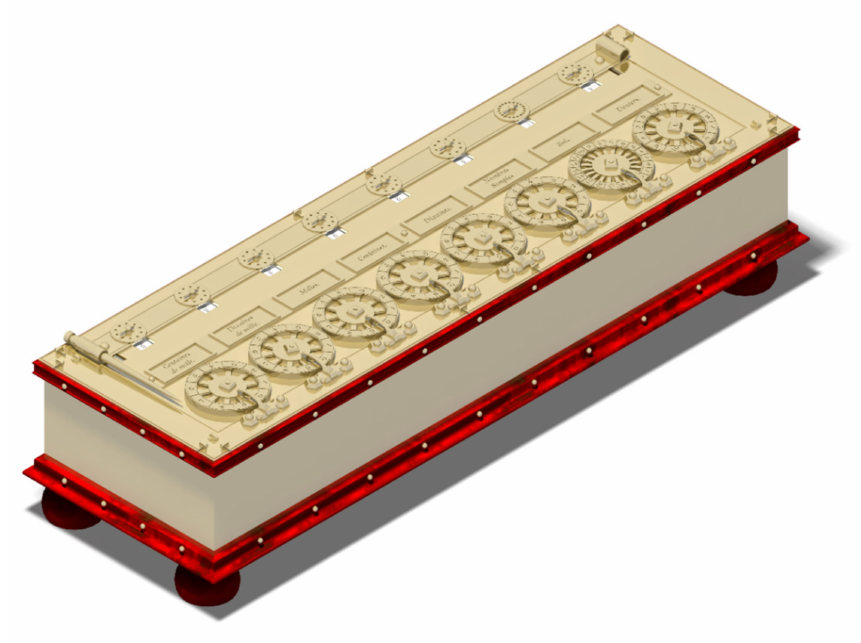
Figure 28. Complete 3D CAD model of the